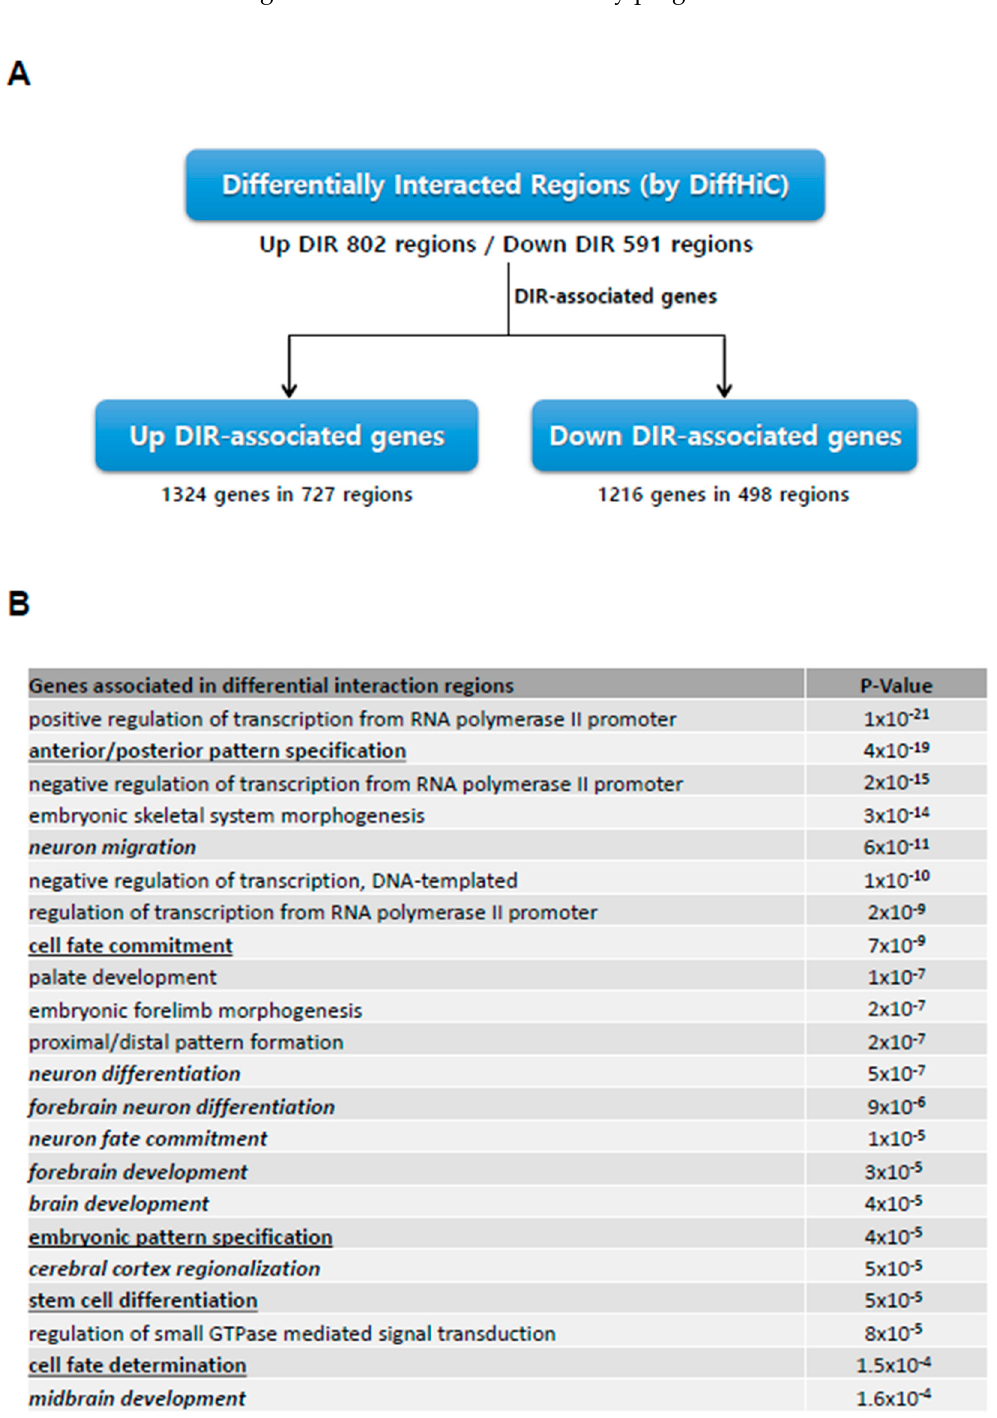
Figure 3. Significant differential interactions reveal role of spatial organization in iPSC to NPC differentiation. ( A ) The number of genes associated with differentially interacting regions (DIRs) derived using the DiffHiC package . ( B ) Gene ontology terms of associated genes from ( A ), whereby up-DIR associated genes are italicized while down-DIR associated genes have been underlined.